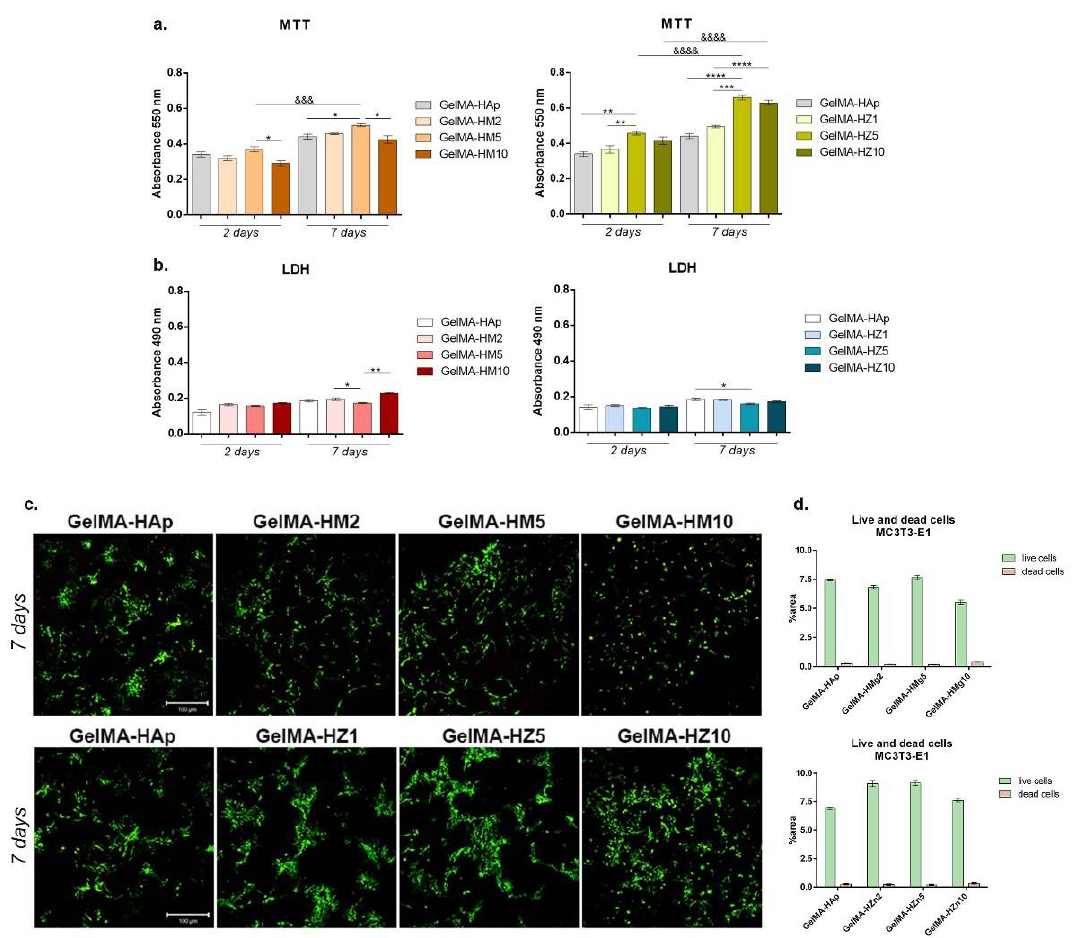
Figure 16. ( a ) Cell viability and proliferation profile registered after MTT test for GelMA-derived composites during one week of culture. Statistical significance: * p < 0.05, ** p < 0.01, *** p < 0.001, **** p < 0.0001, &&& p < 0.001, &&&& p < 0.0001. ( b ) Cytotoxic effect observed by employing LDH assay for the tested composites at two and seven days of culture. Statistical significance: * p < 0.05, ** p < 0.01. ( c ) Live/dead fluorescent coloration indicating with green the live cells and red the dead cells, cultured in contact with printed scaffolds (GelMA-HAp). ( d ) Quantification of green fluorescence (live cells) and red fluorescence (dead cell nuclei) levels in all composites.